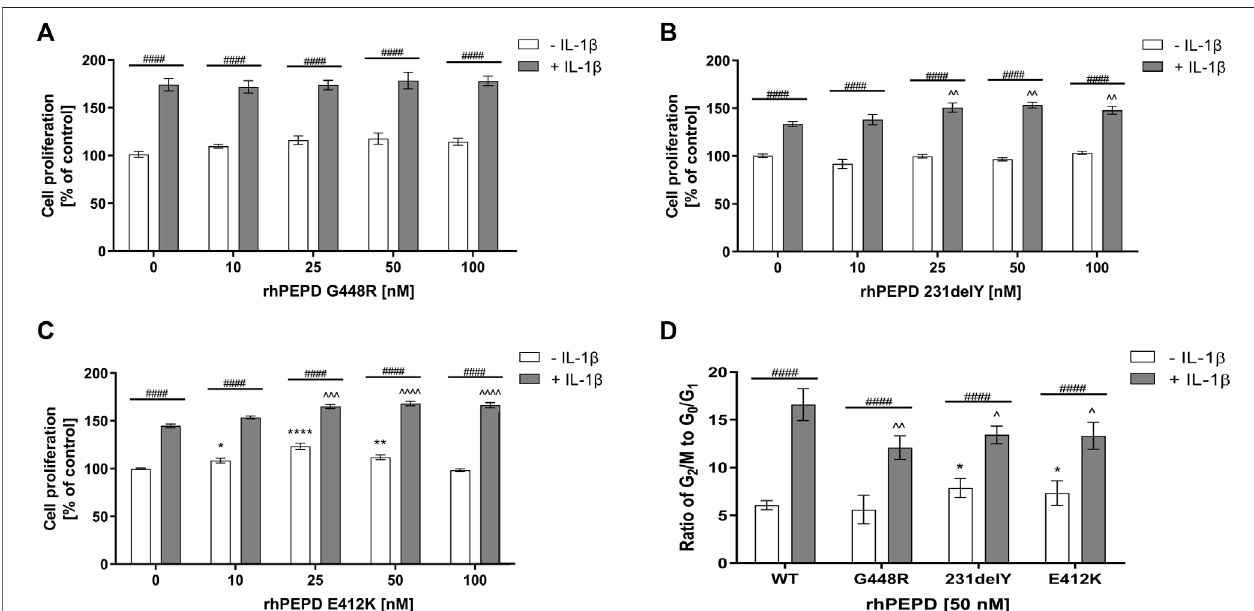
FIGURE 4 | The effect of mutated variants of PEPD (A) rhPEPD-G448R; (B) rhPEPD-231delY; (C) rhPEPD-E412K on HaCaT cell proliferation; (D) Cell cycle analysis presented as a ratio of the cell percentage in G 2 /M to G 0 /G 1 phase in HaCaT cells cultured in the presence and absence of IL-1 β (10 ng/ml). The cells were treatedwithstudiedcompoundsfor24 h.Statisticalsigni fi canceswereexpressedas*, ^ , # p < 0.05,**, ^^ , ## p < 0.01,***, ^^^ , ### p < 0.001and****, ^^^^ , #### p < 0.0001;indicates* vs. control (0 nM of PEPD, without IL-1 β ) cells, ^ vs. control (0 nM of PEPD, with IL-1 β ) cells, # signi fi cance between groups treated with or without IL-1 β ,